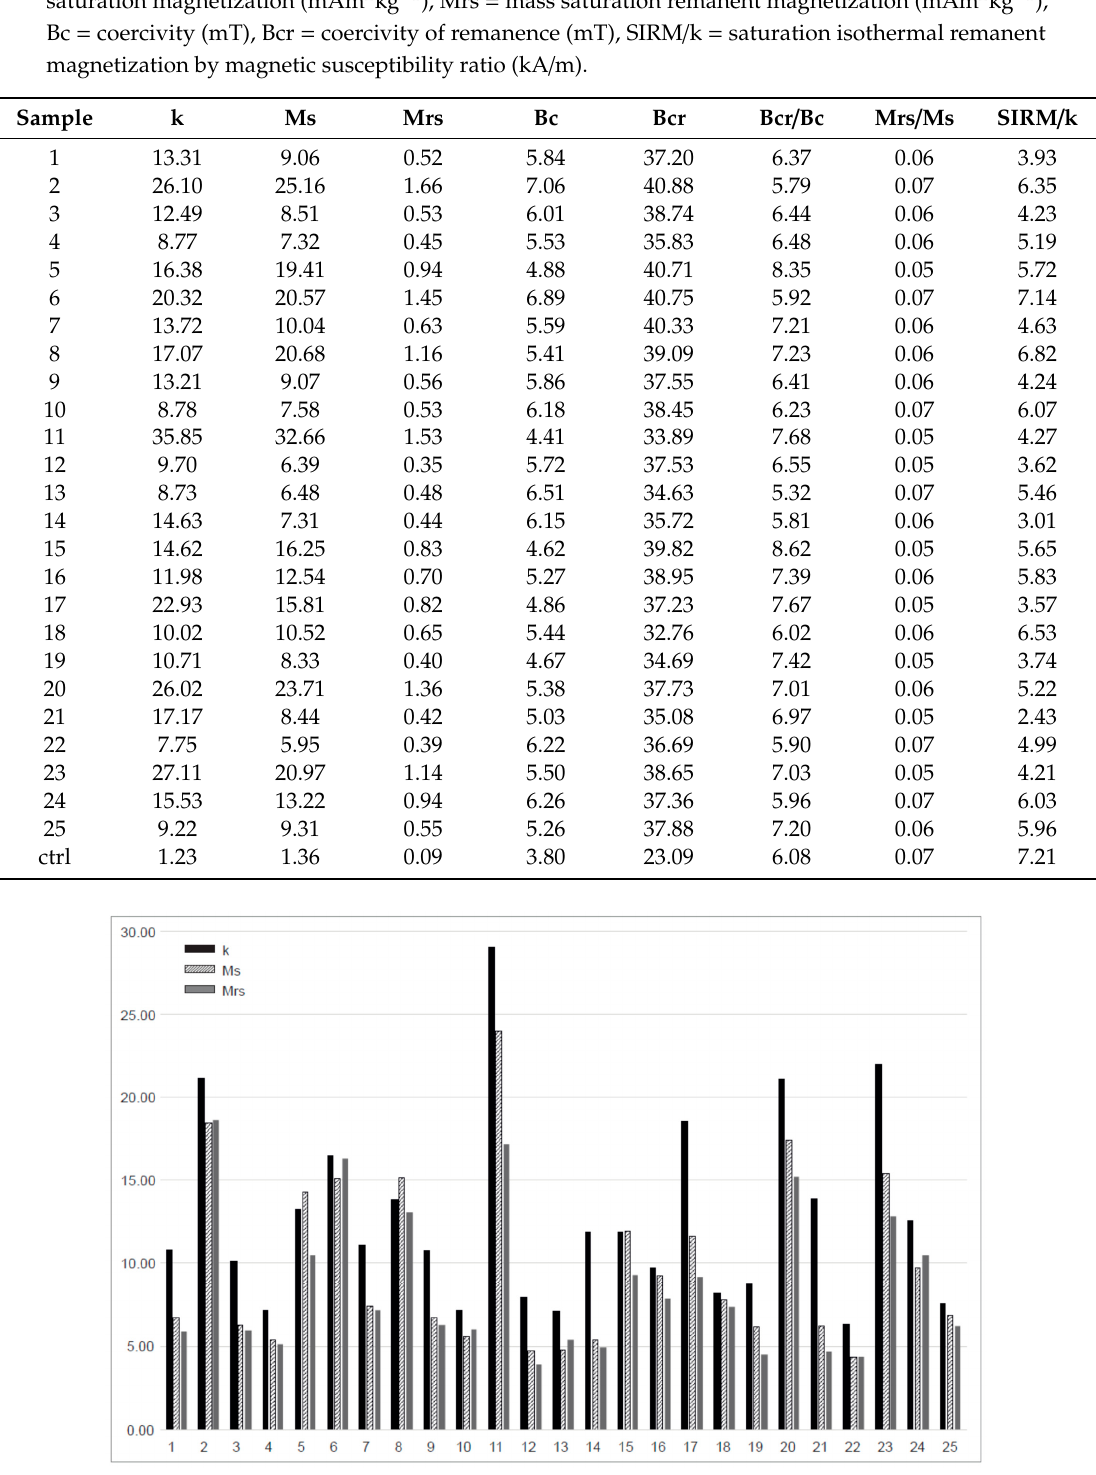
Table 2. Magnetic parameters of samples of the lichen Evernia prunastri exposed for 3 months at 25 sites in Milan, as well as at a control site (ctrl). k = mass magnetic susceptibility (10 − 8 m 3 kg − 1 ), Ms = mass